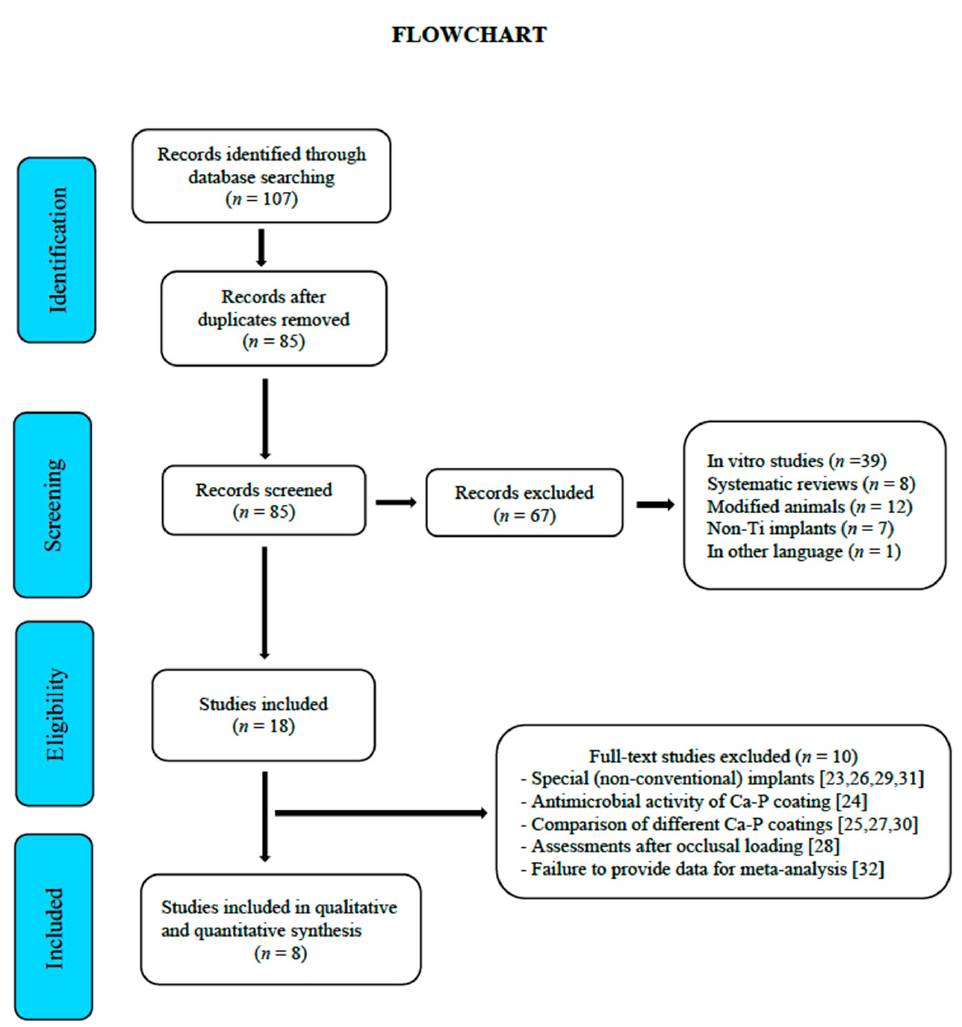
Figure 1. Figure 1. Flowchart.